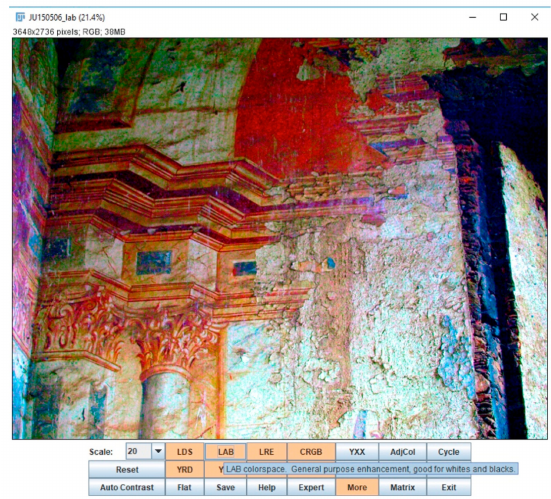
Figure 8. User interface for ImageJ plugin, DStretch ® . The commands and main colourspaces are displayed directly below the image being analysed. Pop-up windows provide the user with helpful information on colourspace